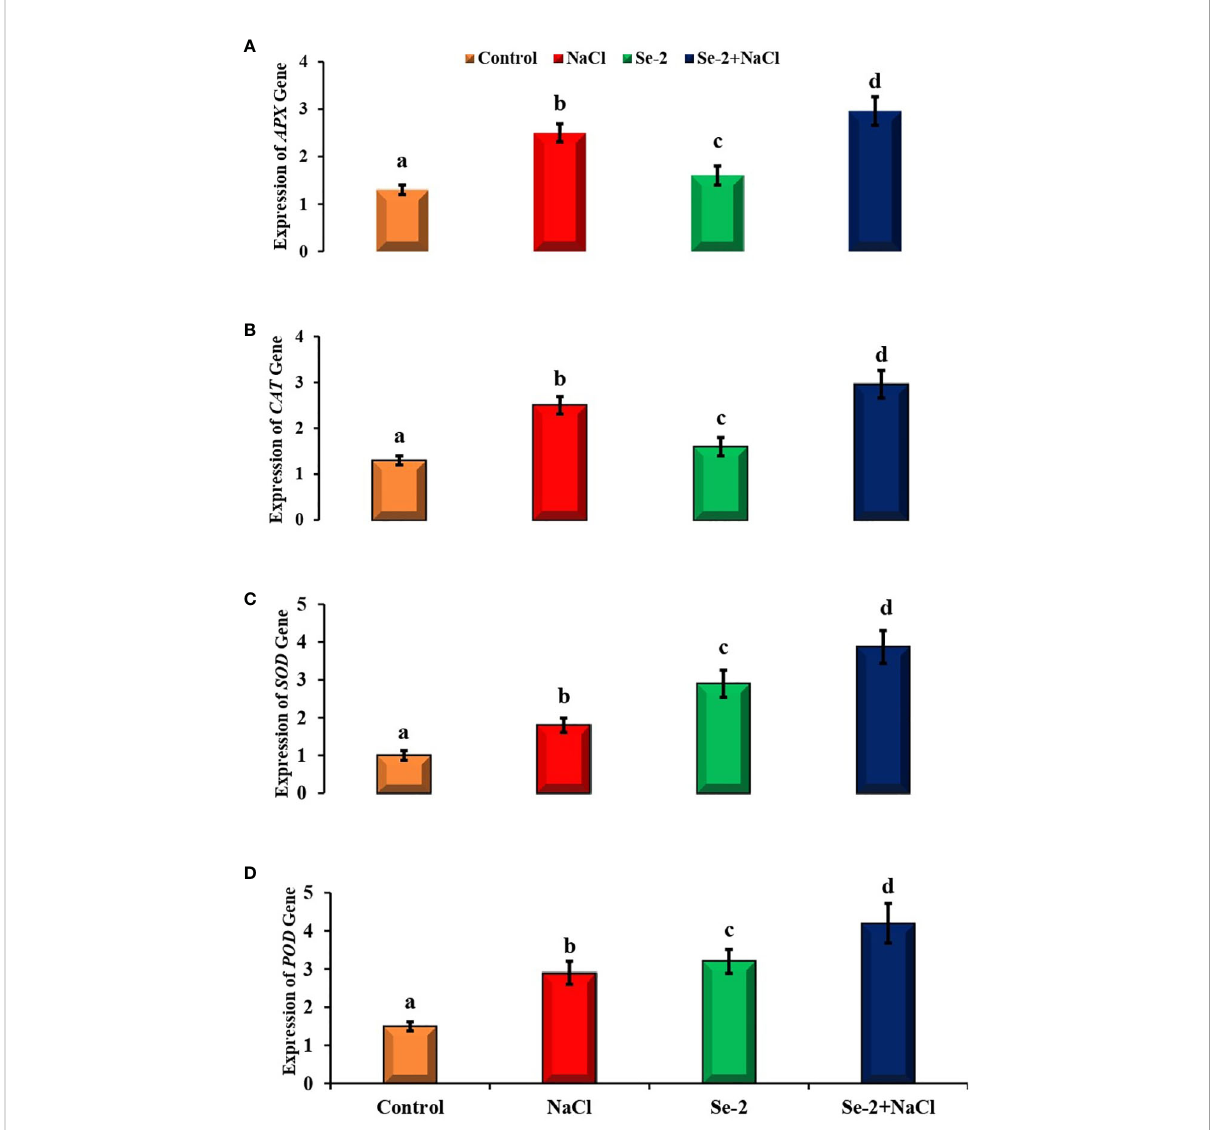
FIGURE 3 Quantitative real-time PCR analysis of the transcript levels of antioxidant defense-related genes in the shoots of turnip plants treated with Se and NaCl. (A – D) Relative expression of the APX (A) , CAT (B) , SOD (C) , and POD (D) genes. Bars represent the mean values of three independent experiments with standard errors. Different letters denote signi fi cant differences between treatments ( p ≤ 0.05). C , control. NaCl = 200 mM NaCl; Se-2 = 100 m mo L − 1